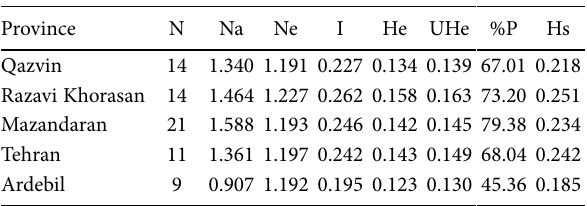
Table 5. Genetic diversity parameters in the studied